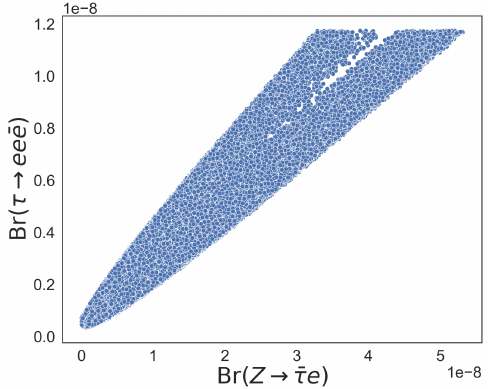
Figure 10 . Scatter plot Br( Z → ¯ τe ) vs. Br( τ → eµ ¯ µ )